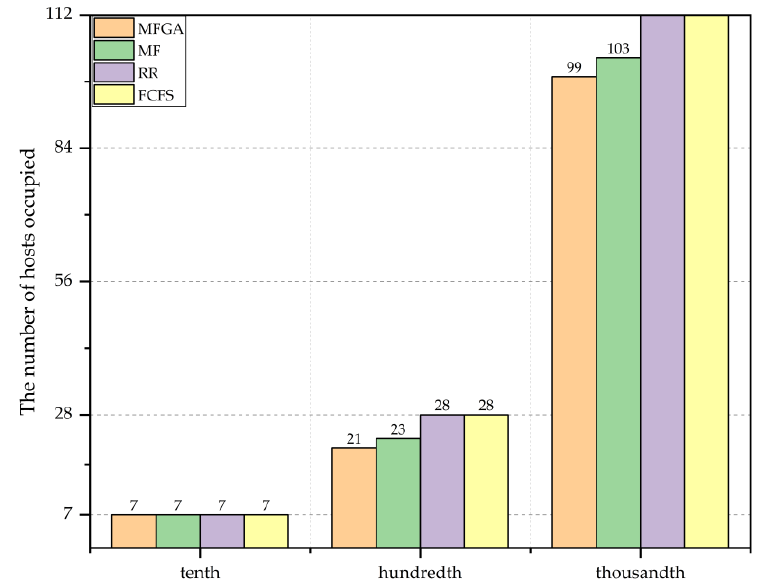
Figure 8. Comparison of the number of hosts occupied compared by four algorithms.